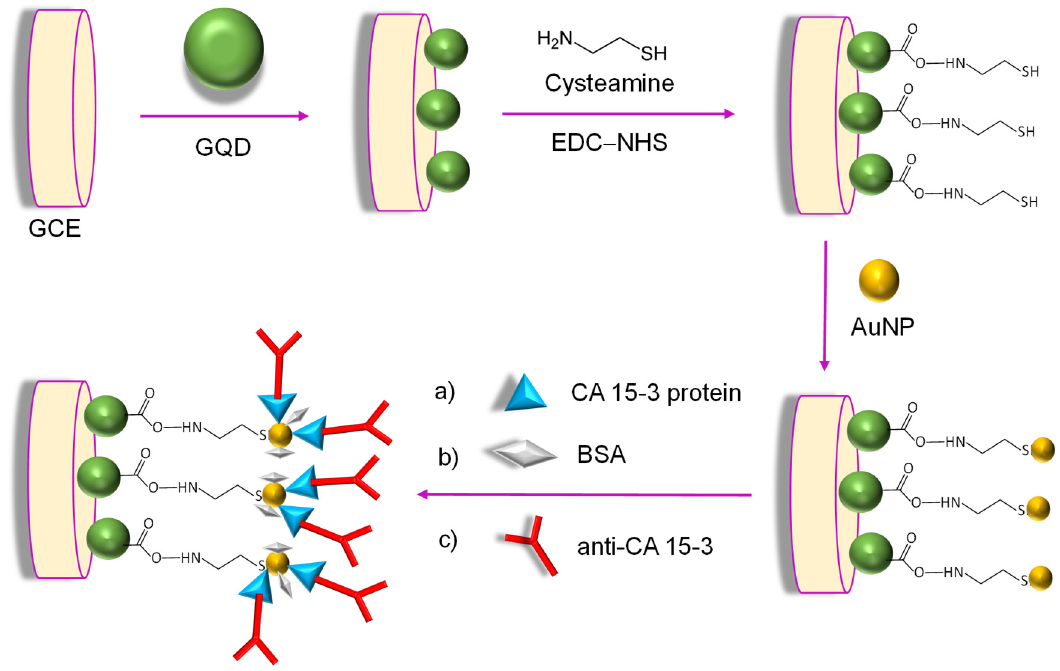
Figure 19. Experimental steps to fabricate a GCE for detecting breast cancer [79].